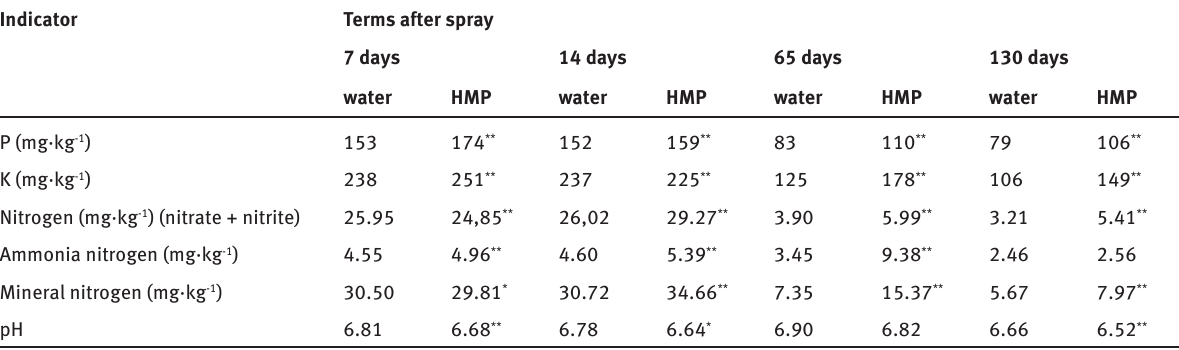
Table 1: Soil data during great pumpkin vegetative period Indicator Terms after spray